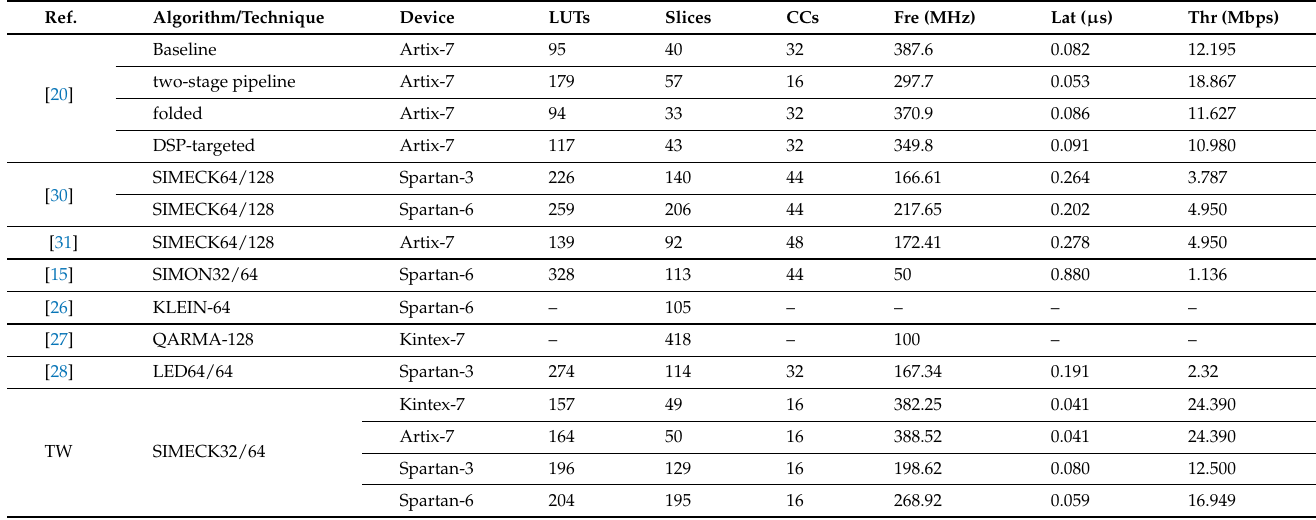
Table 3. The state-of-the-art comparisons of block